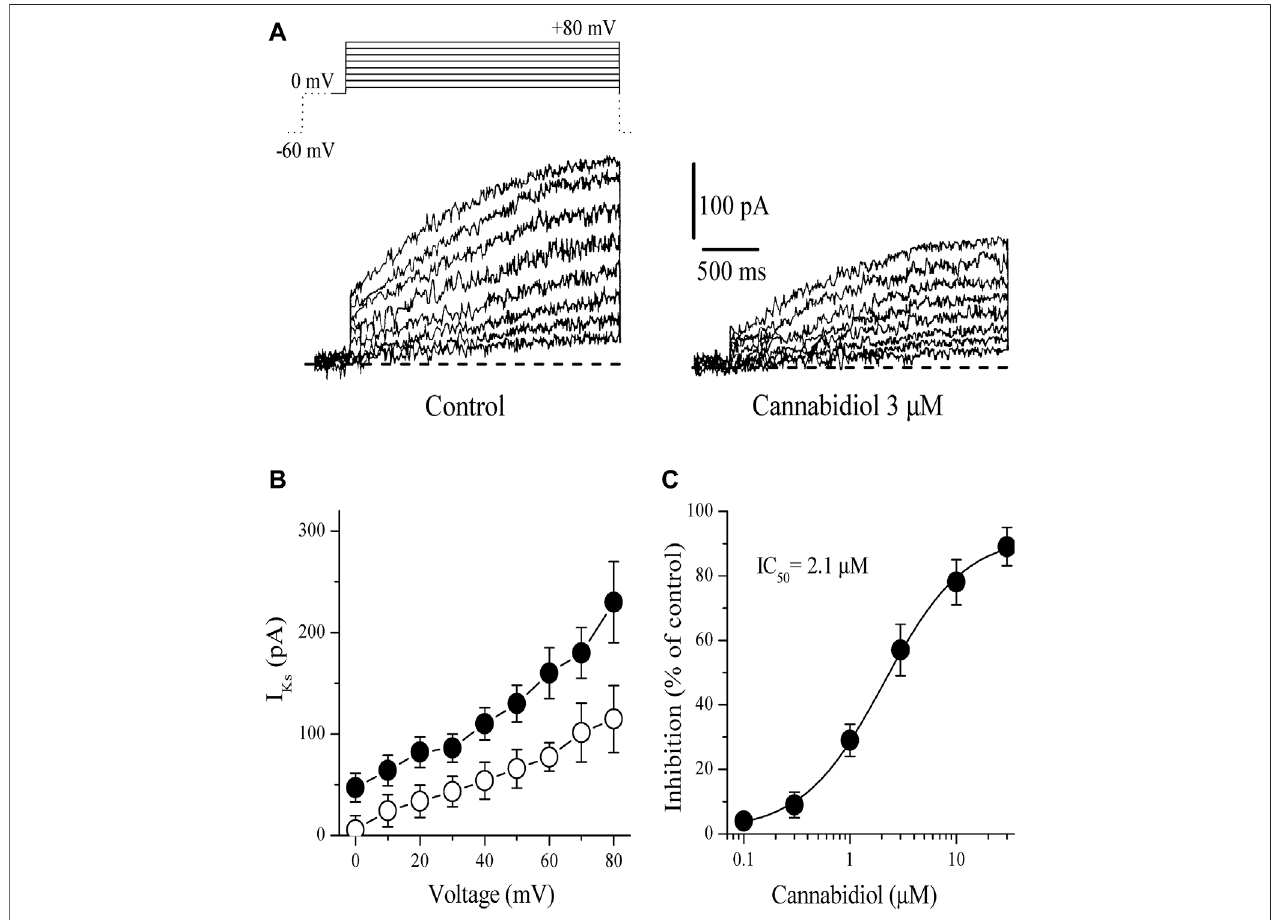
FIGURE 3 | Cannabidiol suppresses the I Ks component of the delayed rectifying I K (A) Original current traces recorded in control conditions (on the left) and after 10 min exposure to 3 μ M CBD (on the right) in rabbit cardiomyocytes. The pulse protocol to activate I Ks is presented in the inset. Only solid lines in the voltage protocols arepresentedincurrenttraces.Dottedlineindicates0 mVbaseline (B) Current-voltagerelationsof I Ks intheabsenceandpresenceof3 μ MCBDarepresentedwith fi lled and open circles, respectively (n (cid:1) 5) (C) Concentration-inhibition curve for CBD inhibition of I Ks (n (cid:1) 4 – 7).